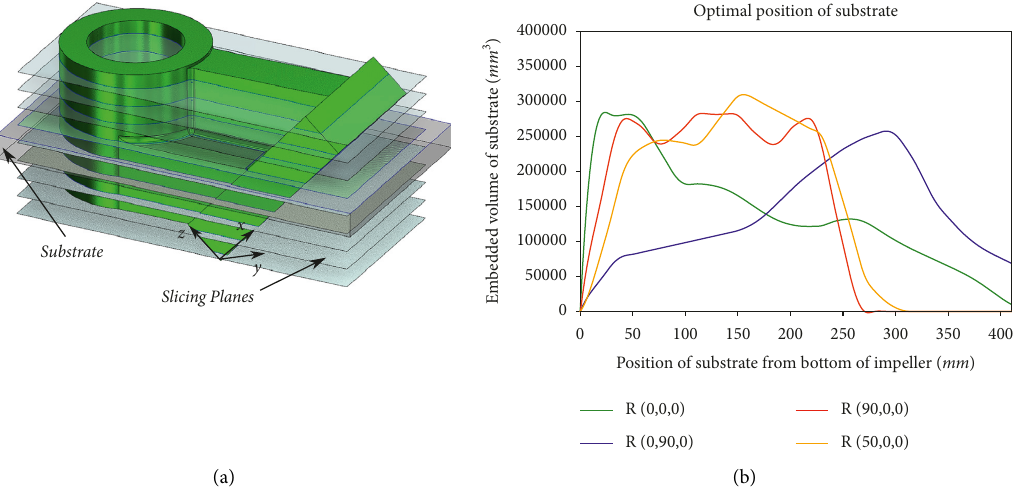
Figure 9: Illustrative example 2: (a) CAD model and (b) VI for different positions of the substrate with different orientations.